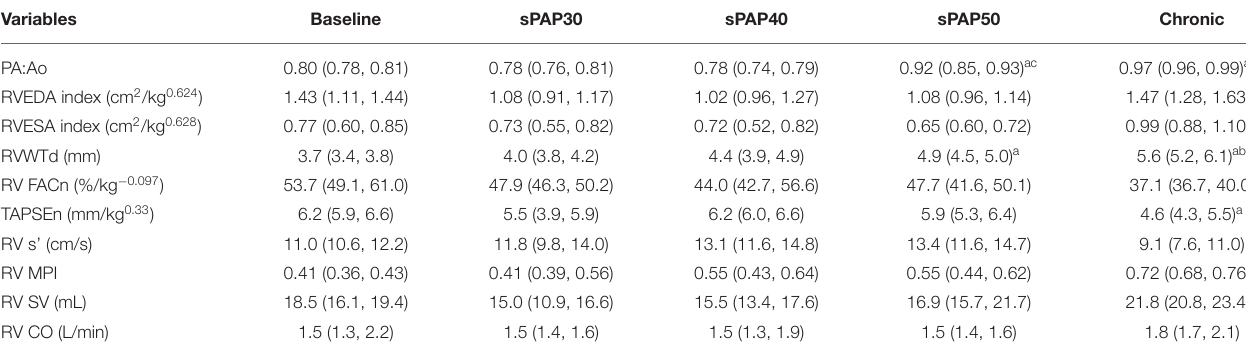
TABLE 2 | Changes in echocardiographic parameters during the process of creating canine models of chronic embolic pulmonary hypertension. Variables Baseline sPAP30 sPAP40 sPAP50 Chronic